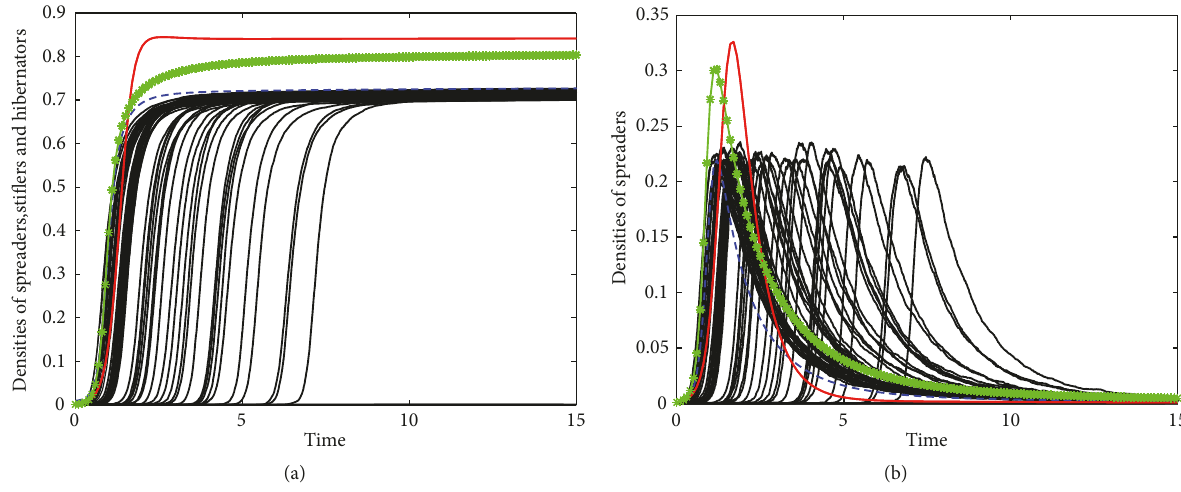
Figure 4: Simulations with 𝜆 = 0.7 , 𝛽 = 0.3 , 𝛼 = 0.2 , 𝛿 = 0.1 , 𝜉 = 0.1 , and 𝜂 = 0.1 . The black lines correspond to 100 Monte Carlo simulations trajectories for an SIHR rumor model in a network with the refined power-law degree distribution. The red solid lines and green star lines represent numerical simulation trajectories based on the mean-field system in [13] and [21], respectively. The dashed blue lines represent numerical simulation trajectories based on the system (3). (a) The trajectories of the densities of spreaders. (b) The trajectories of the densities of spreaders, stiflers, and